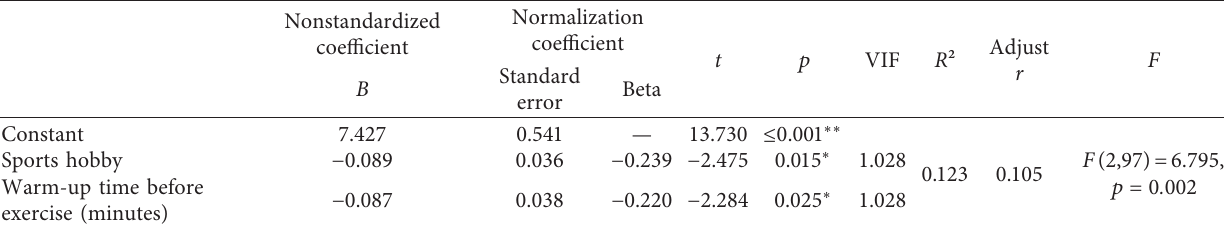
Table 10: Stepwise regression analysis ( n �